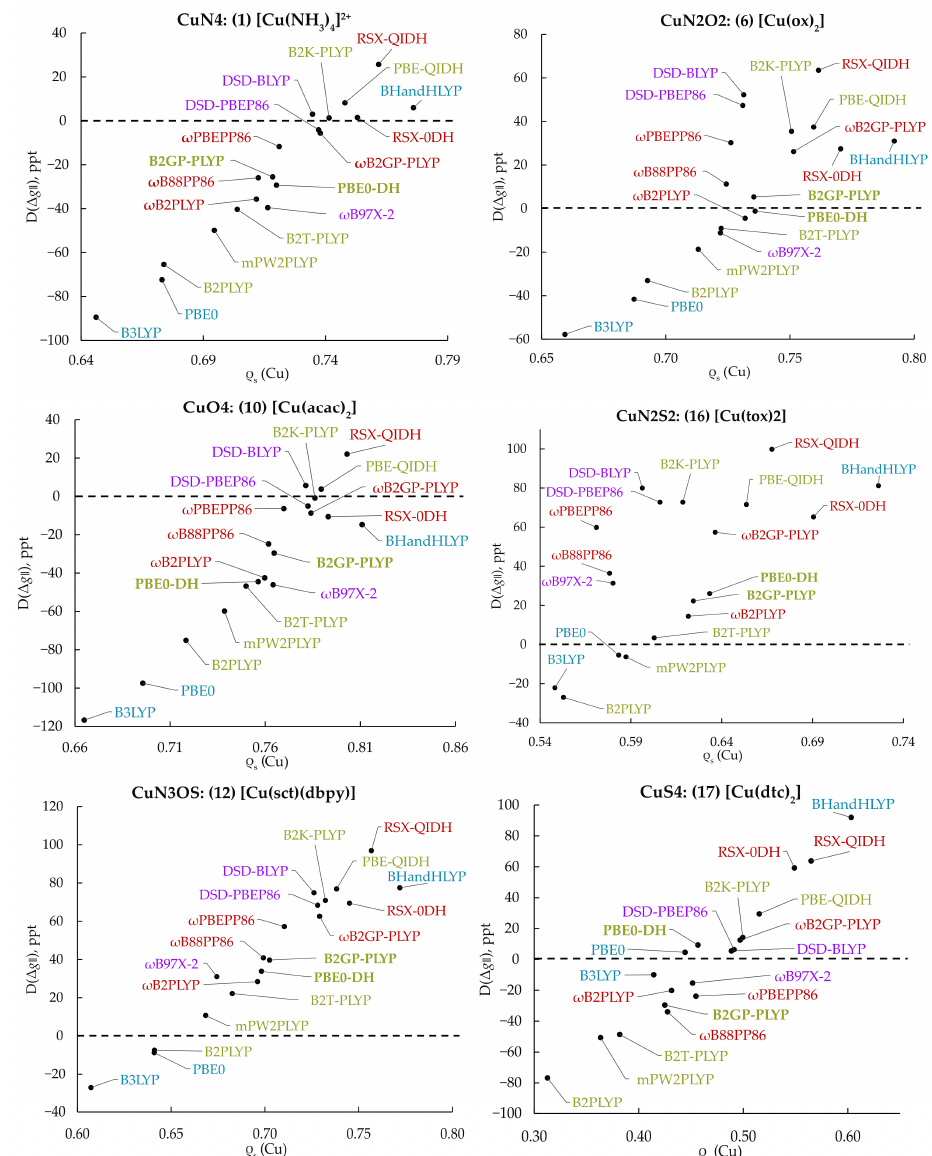
Figure 3. Correlation of the differences, D( ∆ g (cid:107) ), of the calculated g -tensor from the experimental value of the parallel g -shift with the Cu spin populations computed with the respective functional for complexes 1 , 6 , 10 , 16 , 12 and 17 , which have different copper coordination spheres.